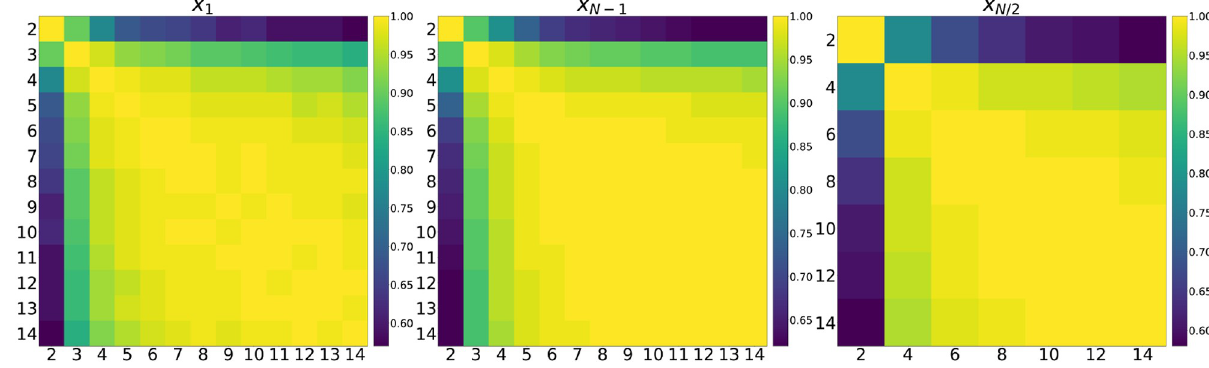
Fig 10. Heatmap of correlation coefficients of rankings by population